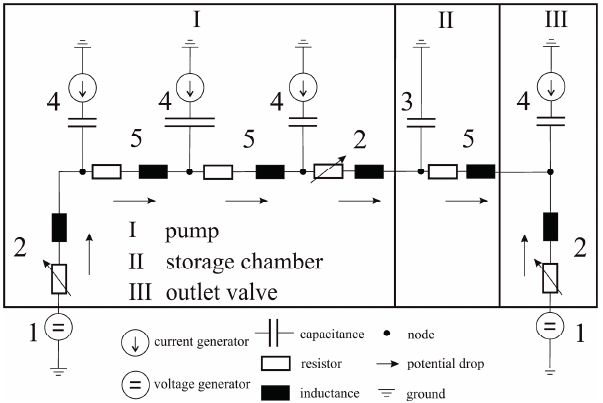
Figure 4. Schematic of the lumped parameter model. Element 1: source pressure applied at the inlet and outlet. Element 2 is the valve, and element 3 is the storage capacitance. Element 4 represents a piezo-electrically actuated membrane and element 5 is the fluidic resistance between two